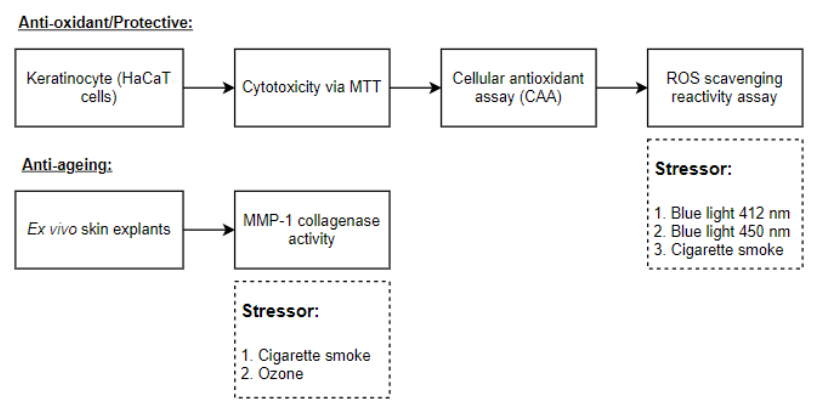
Figure 1. A graphical scheme of the study.